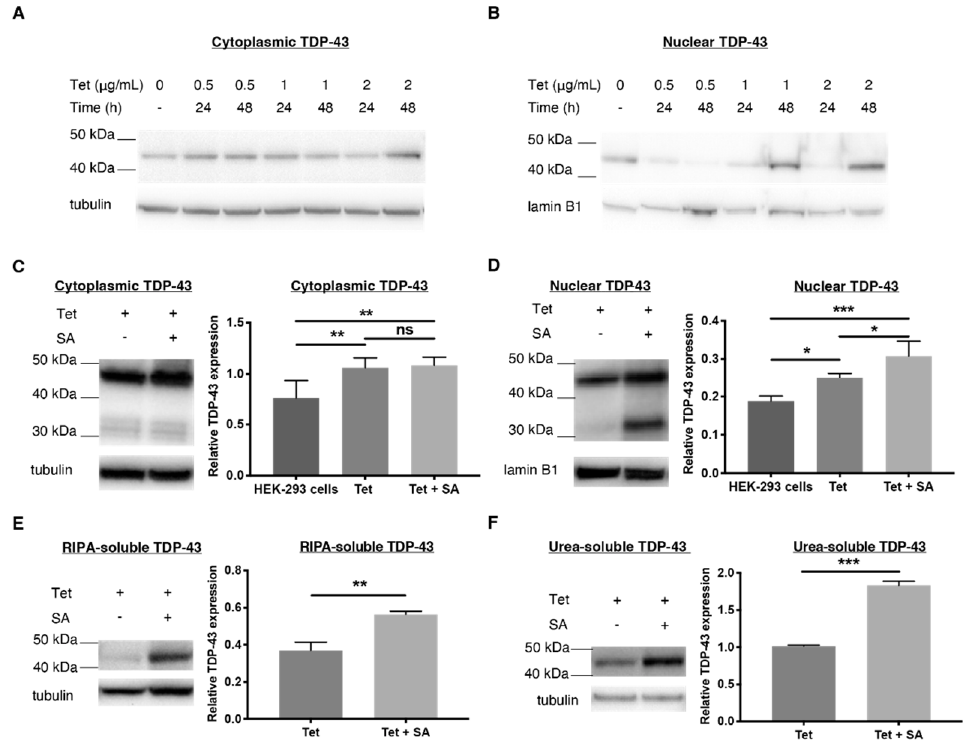
Figure 1. Comparing TDP-43 expression levels in human embryonic kidney (HEK-293) cells stably transfected with tetracycline (Tet)–inducible WT TDP-43 using Western blots. Cells were treated with varied concentrations of Tet (µg/mL) for different time periods. ( A , B ) The Western blot shows overexpression of TDP-43 in the cytoplasm and nucleus of transfected HEK-293 cells treated with 2 µg/mL of Tet for 48 h. ( C , D ) The quantified expression of TDP-43 in the cytoplasm and nucleus after treatment with Tet (2 µg/mL, 48 h) with and without sodium arsenite (SA, 15 µM, 18 h), an oxidative stressor, to encourage TDP-43 translocation and formation of stress granules. ( E , F ) RIPA- and urea- soluble fractions of transfected HEK-293 cells were stained for TDP-43. TDP-43 is normalised to α -tubulin for the cytoplasmic, RIPA-soluble and urea-soluble fractions and lamin B1 for the nuclear fraction. Data represent mean ± SD, n ≥ 3, and significant differences between means were examined with a one-way ANOVA with Tukey’s multiple comparison test. * p < 0.05, ** p < 0.01, *** p < 0.001, ns: not significant.